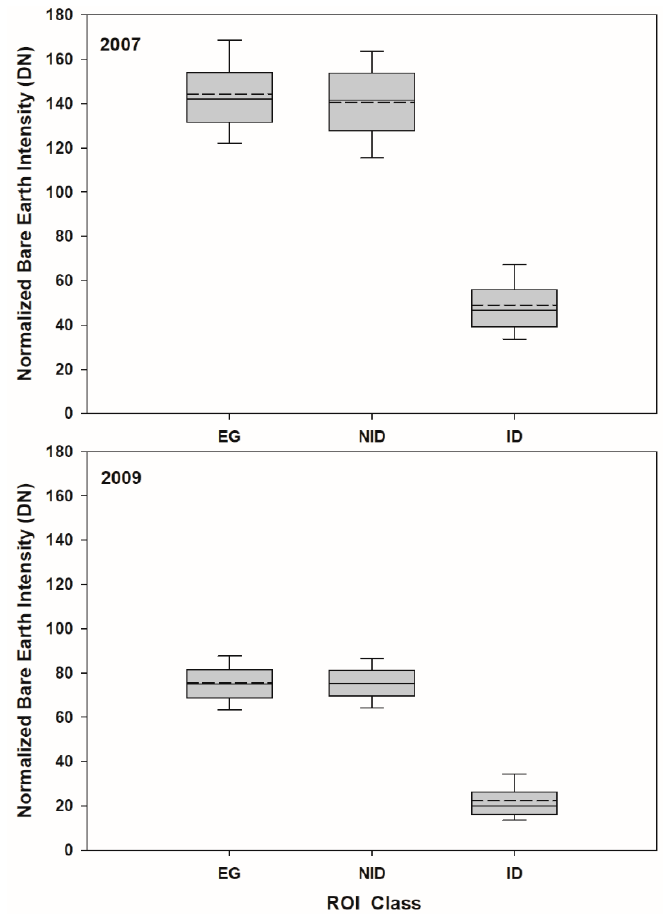
Figure 5. Statistics for evergreen (EG), non-inundated deciduous (NID), and inundated deciduous (ID) ROIs collected from the normalized 27 March, 2007 (top) and 24 March, 2009 (bottom) bare earth intensity images as digital numbers (DN). Statistics include mean (dash line), median (solid line), 10th percentile (lower whisker), 25th percentile (lower box extent), 75th percentile (upper box extent), and 90th percentile (upper whisker). Note that after normalization the evergreen and non-inundated deciduous values are similar, while inundated deciduous values are significantly different.